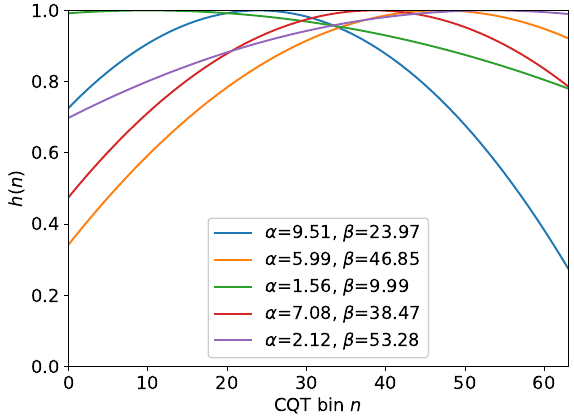
Figure 1. Five examples of random equalization functions h ( n ) over n ∈ [ 0 : 63 ]